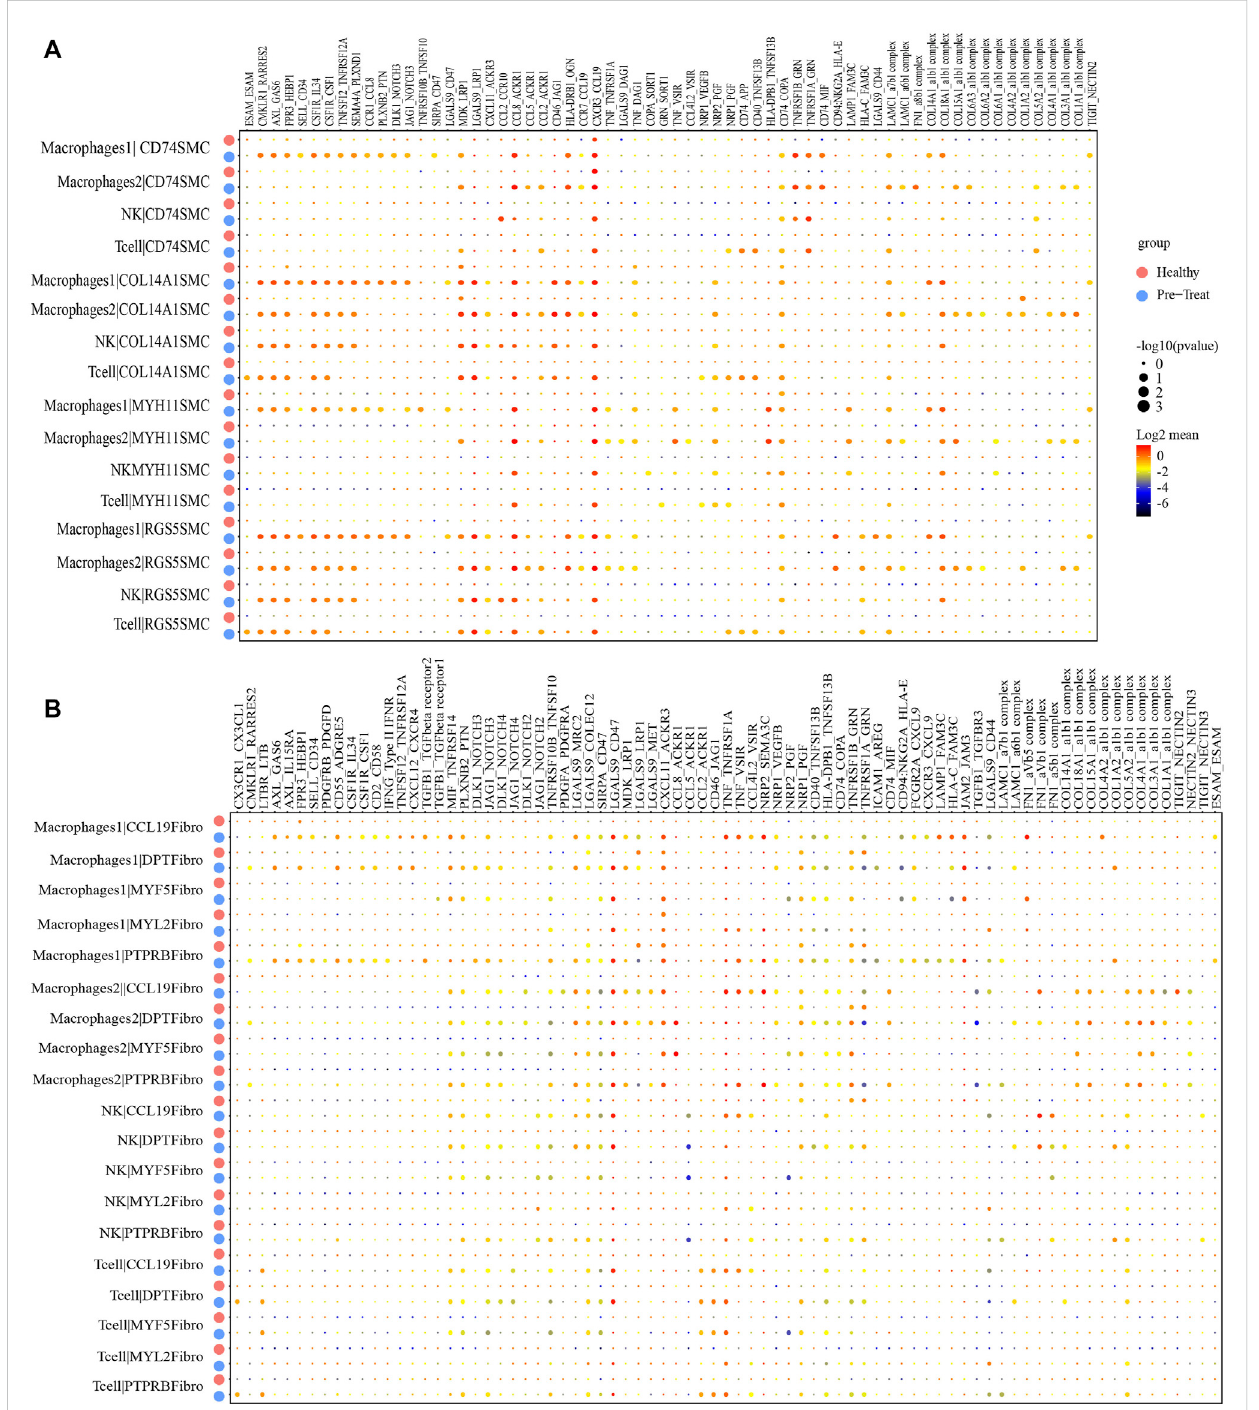
FIGURE 8 Cellular interaction analysis between immune cells and smooth muscle cells or fi broblasts in JDM muscle samples. (A, B) Bubble chart showing ligand-receptor relationship between immune cells and smooth muscle cells (A) or fi broblasts (B) .